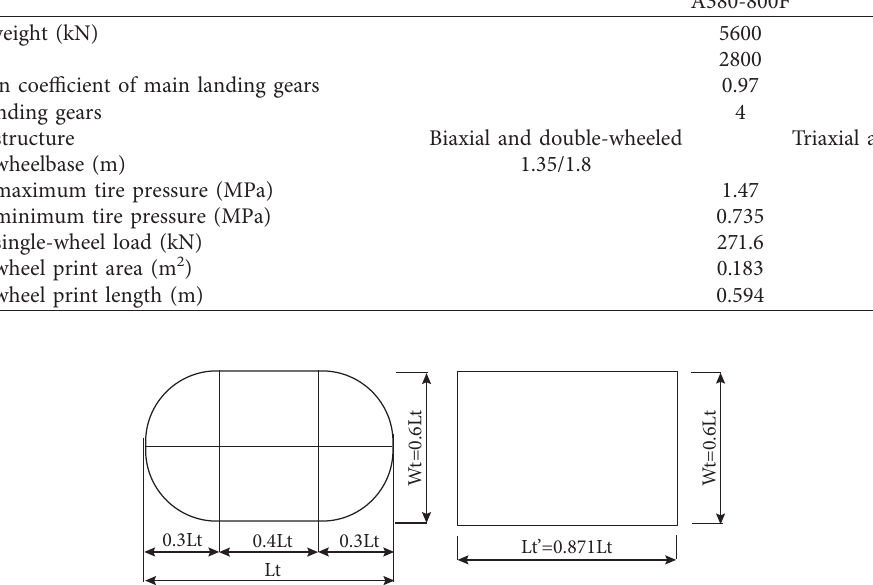
Figure 3: Shape of aircraft wheel prints.